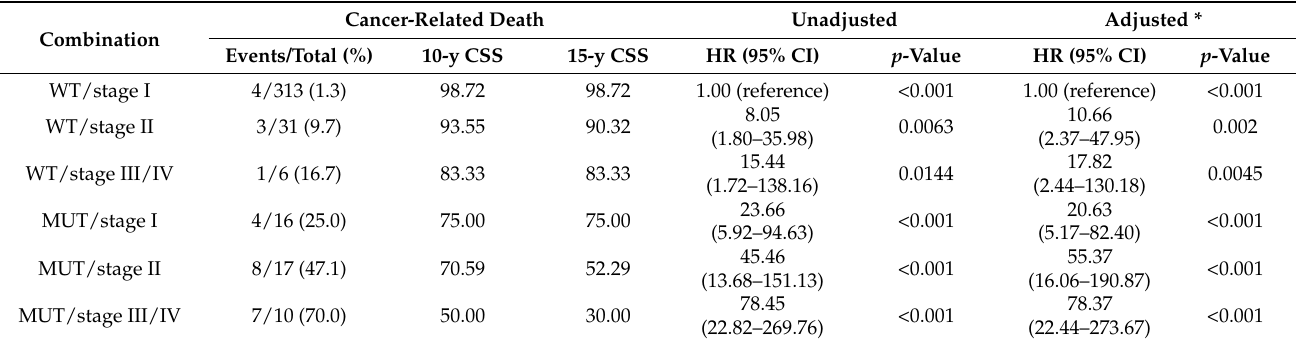
Table 2. Hazard ratios of 6 combinations of TNM-8 stage and TERT promoter mutation status for cancer-related death.